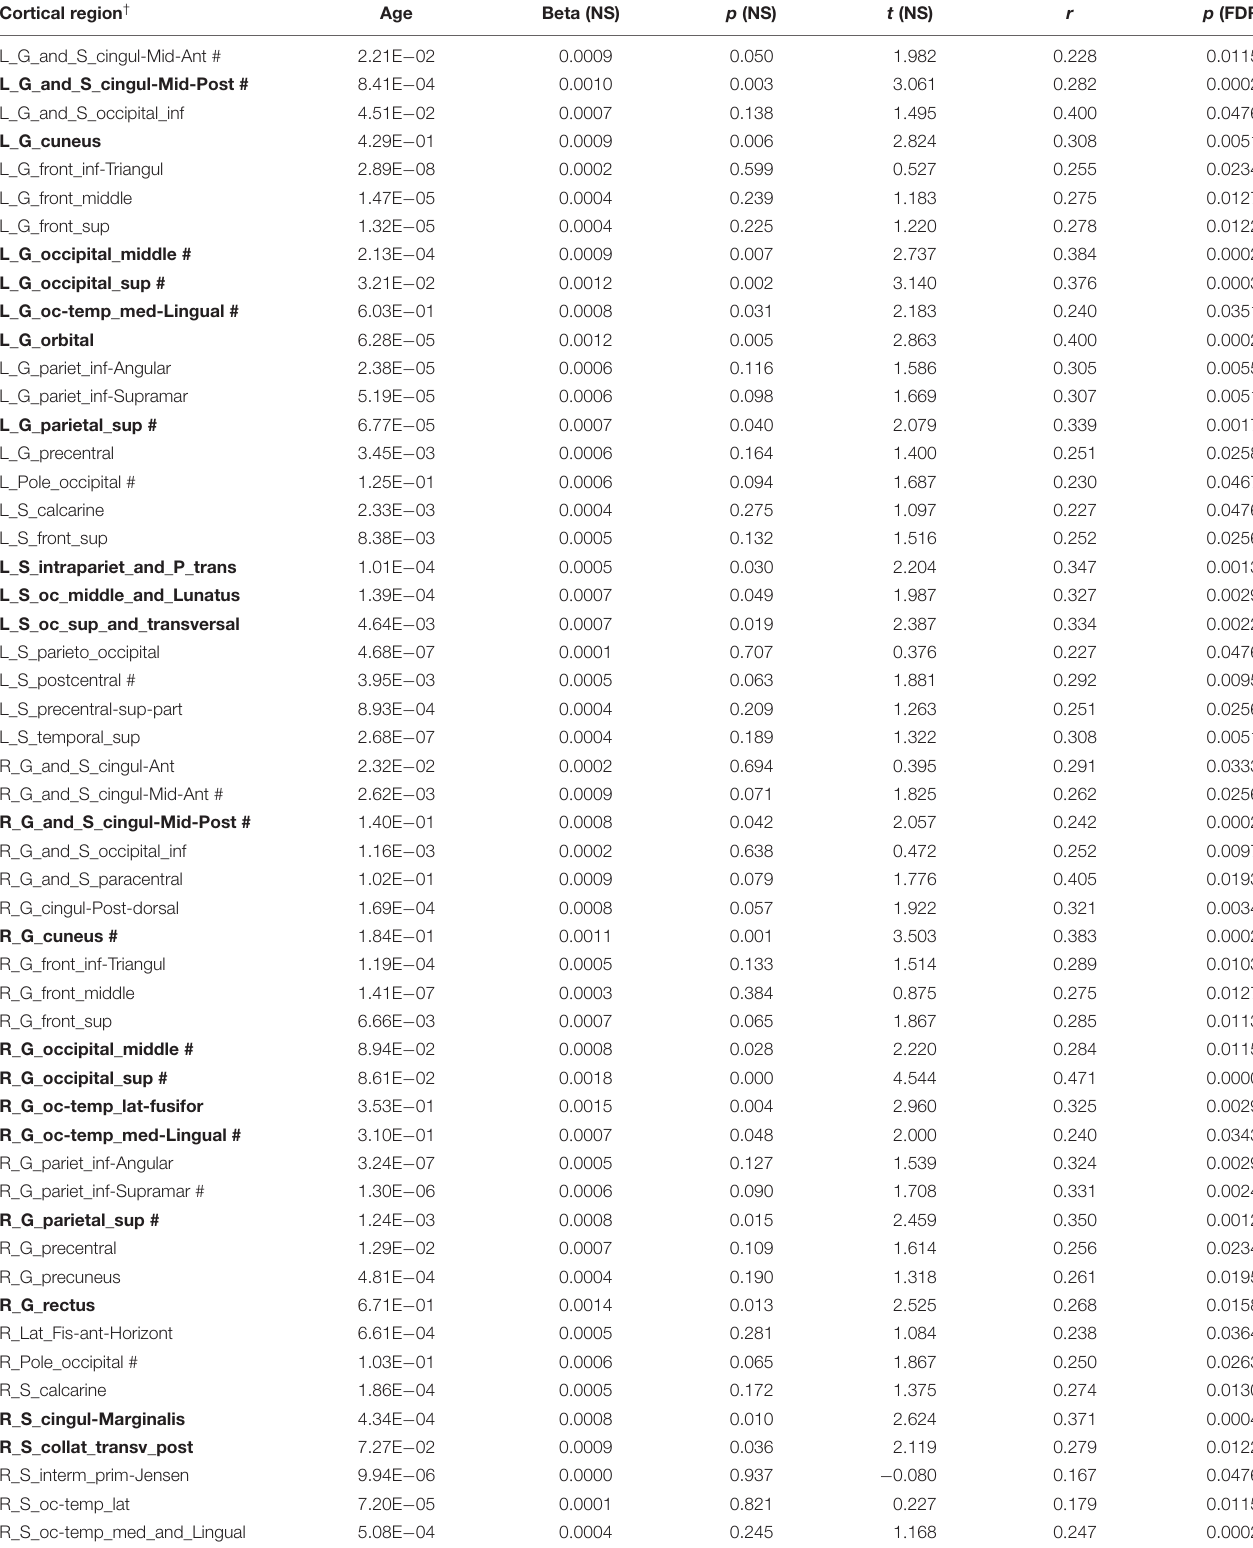
TABLE 3 | Allopregnanolone association with cortical